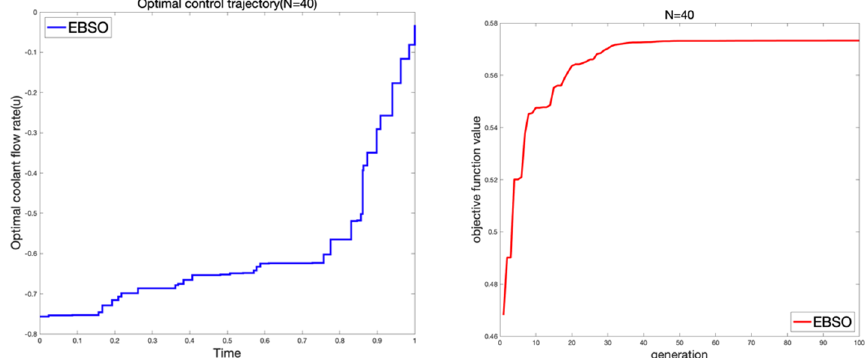
Figure 36. Optimal control trajectory and iteration curve ( N = 40).